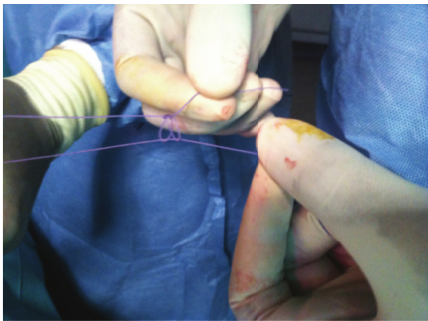
Figure 3: Extracorporeal knot used for ligation of the base of the appendix.